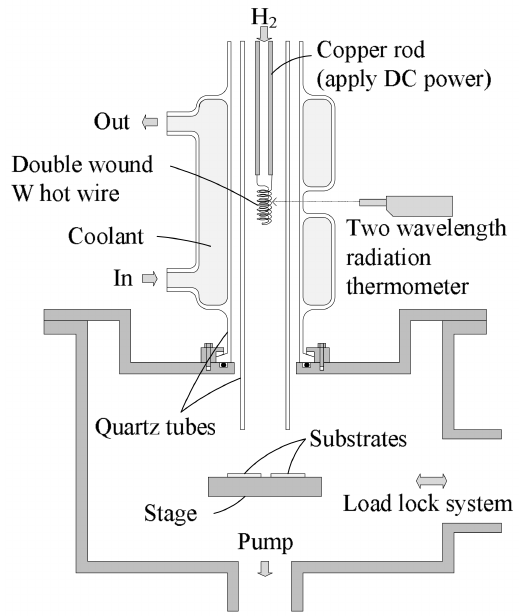
Figure 1. Schematic of the remote-type hot-wire tool.